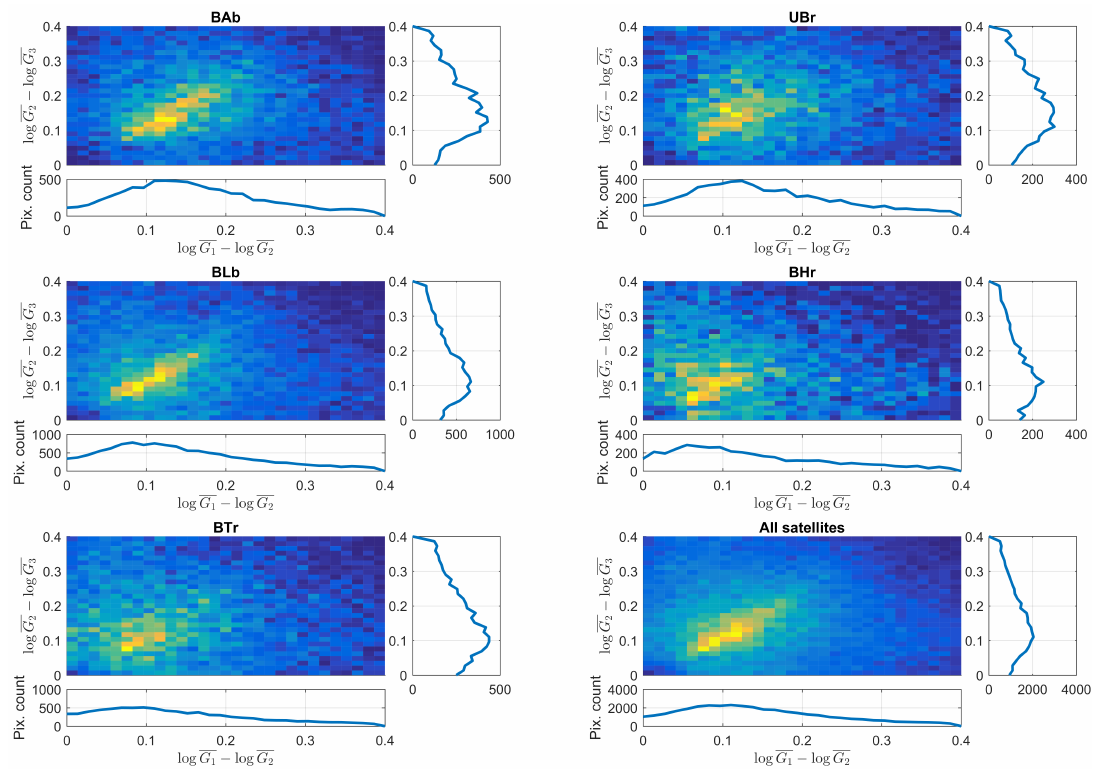
Figure 13. Relations of prefactors in tristable